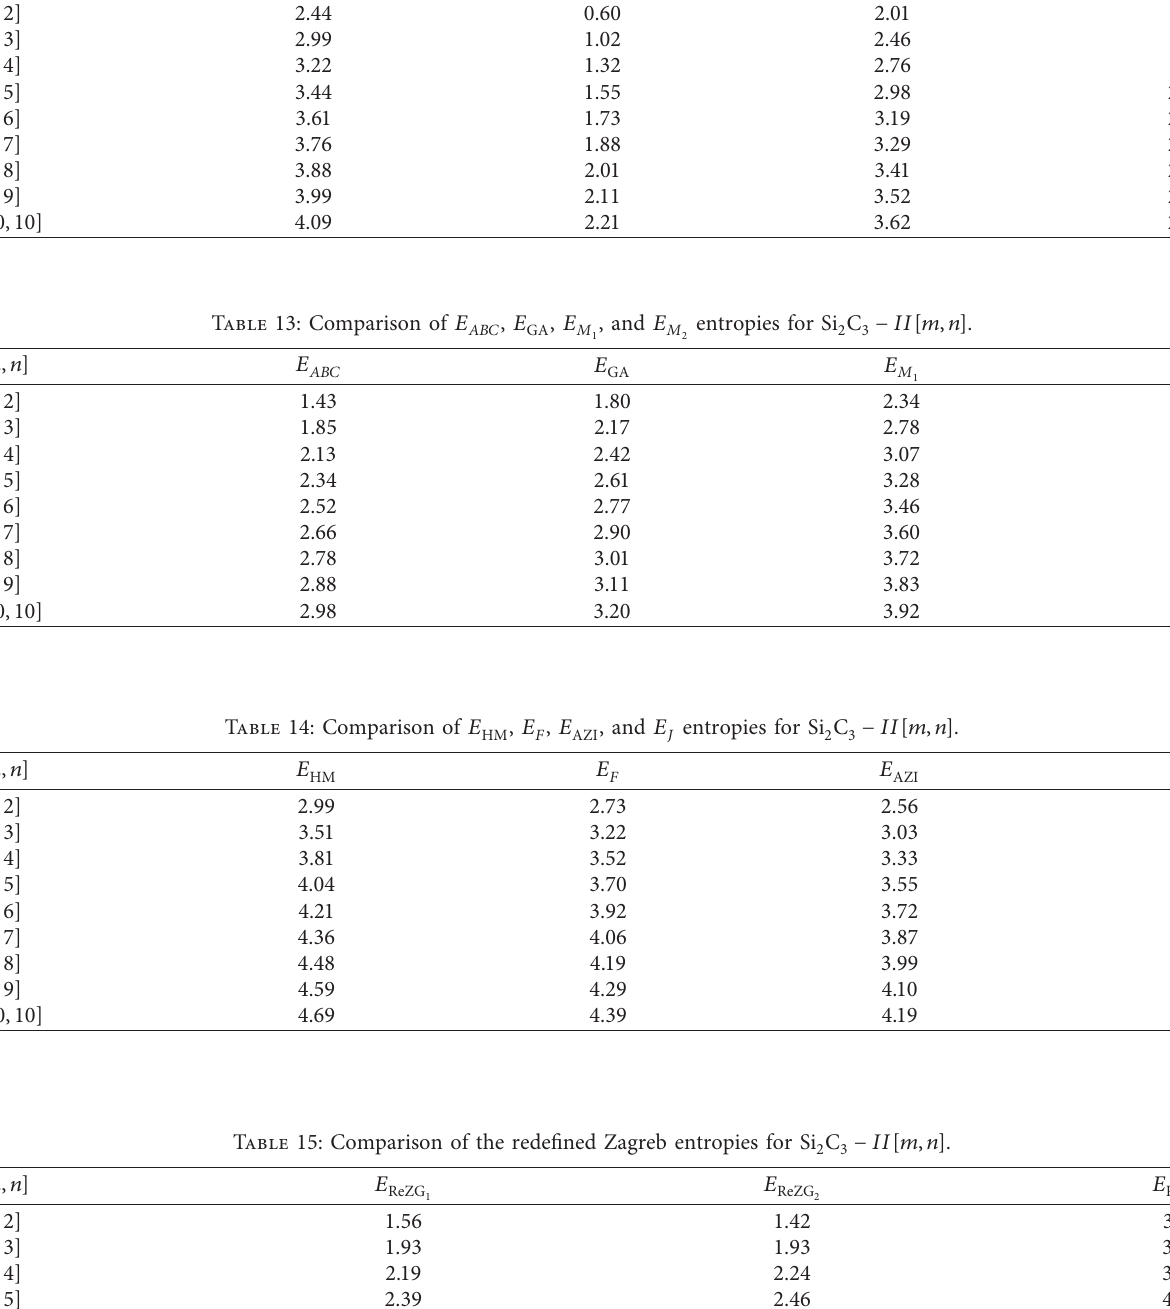
Table 12: Comparison of Randi´c entropies for Si